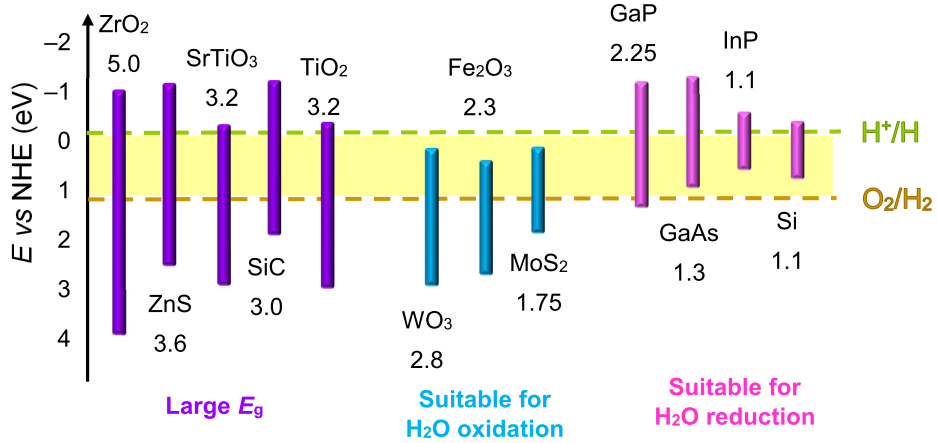
Figure 29. Energy gap (in eV) and band edge positions of some semiconductors relative to normal hydrogen electrode (NHE) (inspired by references [218,219]). The reduction potential of H + /H 2 and the oxidation potential of O 2 /H 2 O are also reported.